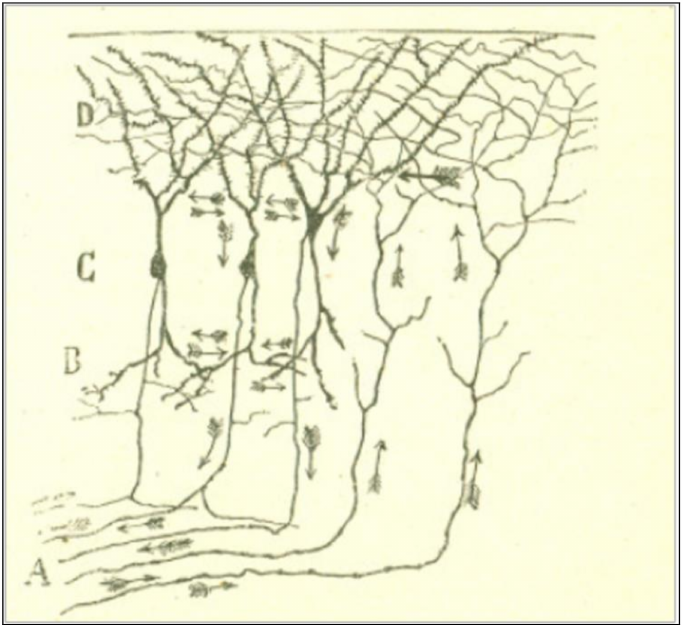
Figure 3. A scheme of the nerve-protoplasmic connections of the cerebral cortex of reptiles. Taken from Cajal [5] (p. 7), out of